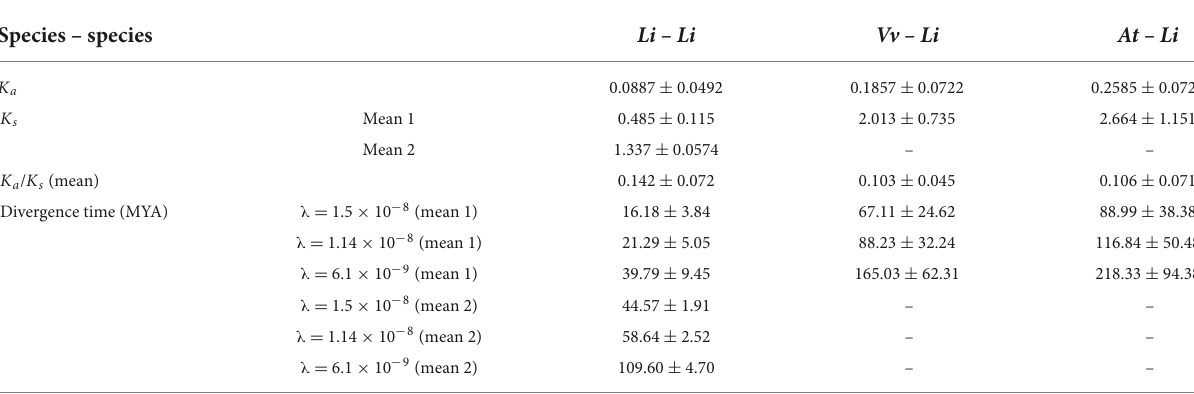
TABLE 2 Divergence time of CIPKs among three